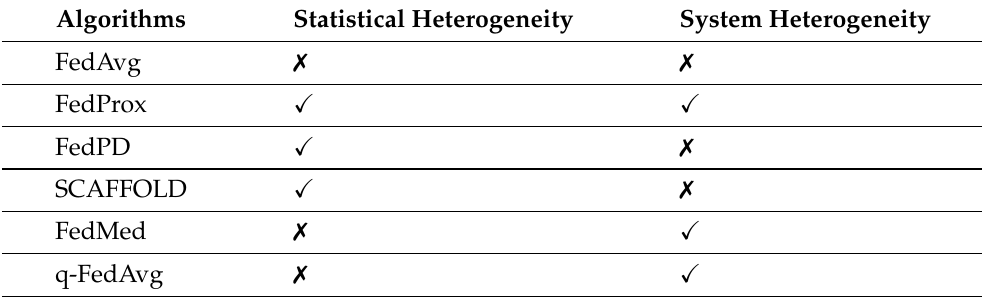
Table 2. FL algorithms and incorporated heterogeneity types.